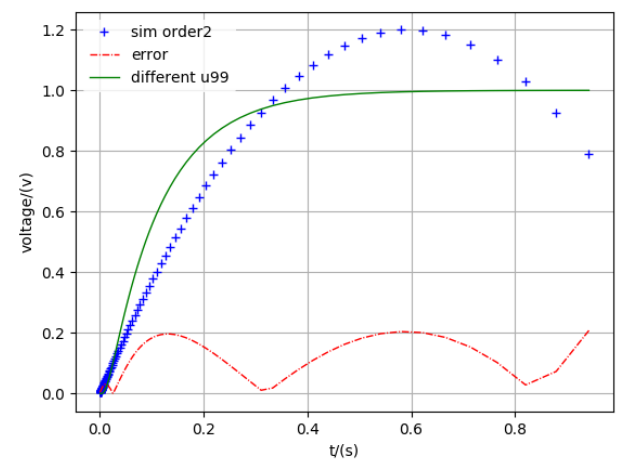
Figure 3. Simulation